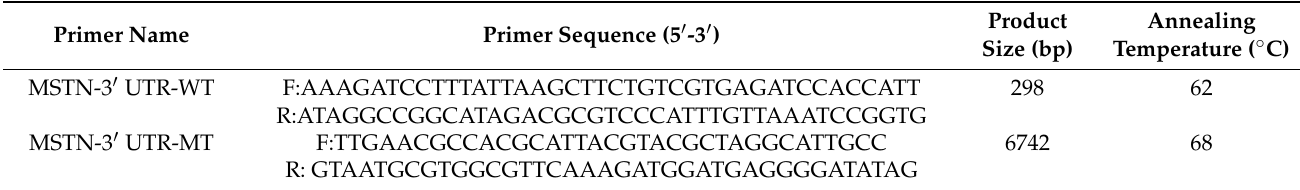
Table 4. Primers used for vector